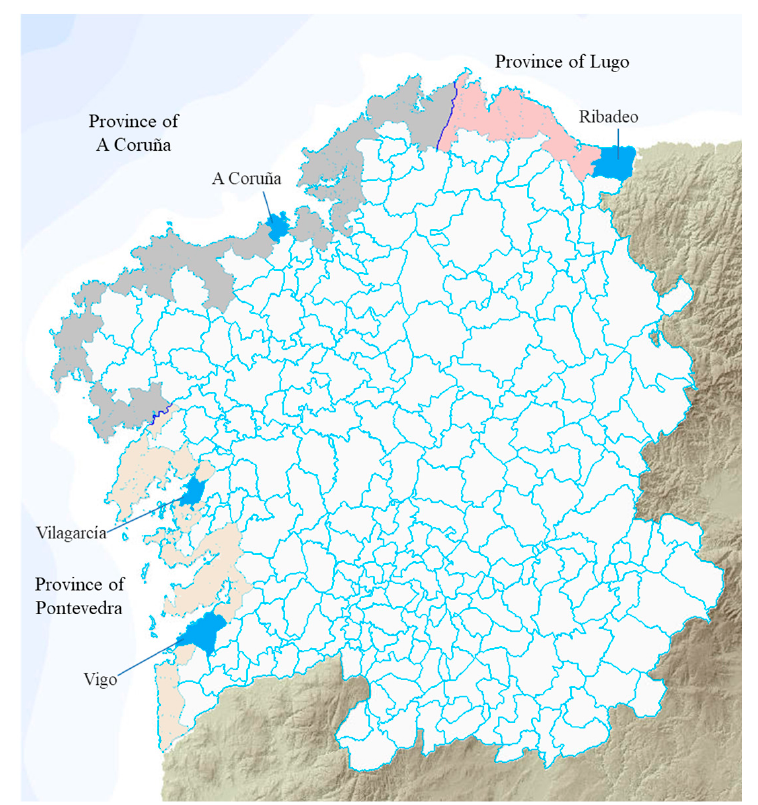
Figure 5. Location of the four communities studied.